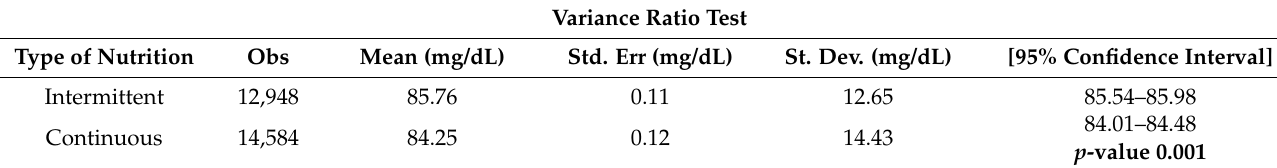
Table 8. Variance ratio test based on weight for gestational age.